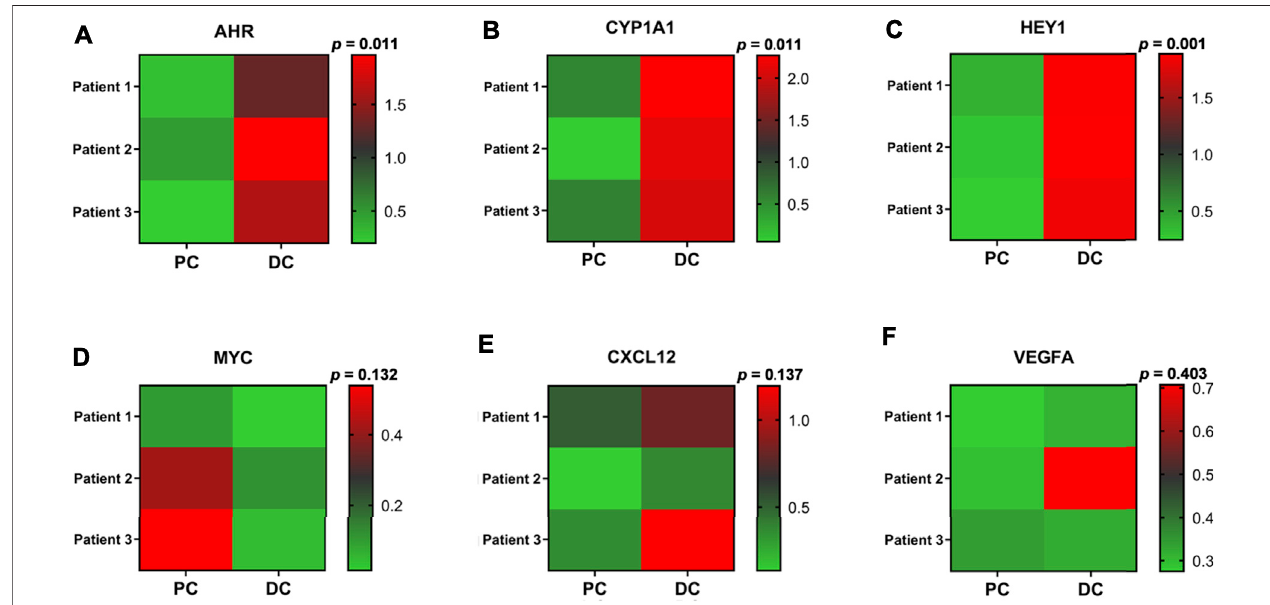
FIGURE 6 | Clinical validation. (A – F) Heat maps of the relative expression of several identi fi ed knee OA-related key genes in osteoarthritic cartilage derived from knee OA patients. p , P-value; PC, preserved cartilage; DC, degenerated cartilage.